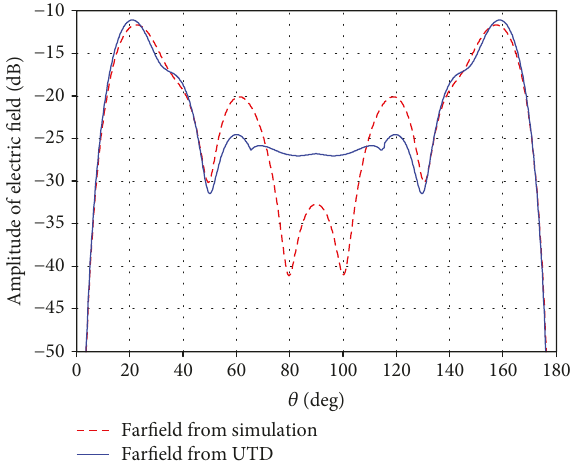
Figure 10: Absolute value of electric fi eld in the ϕ =45 ° plane with w =4 λ and h =1 λ , at 4 GHz compared with simulation result.